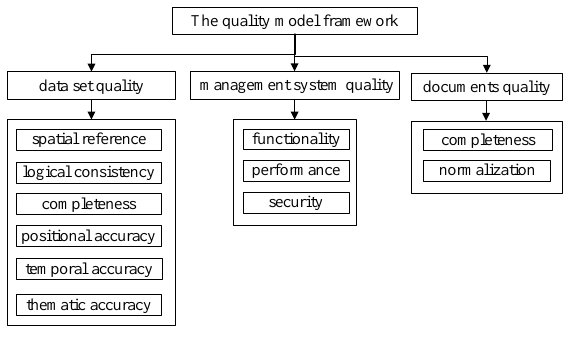
Figure 1. The quality model framework for the fundamental geographic information database